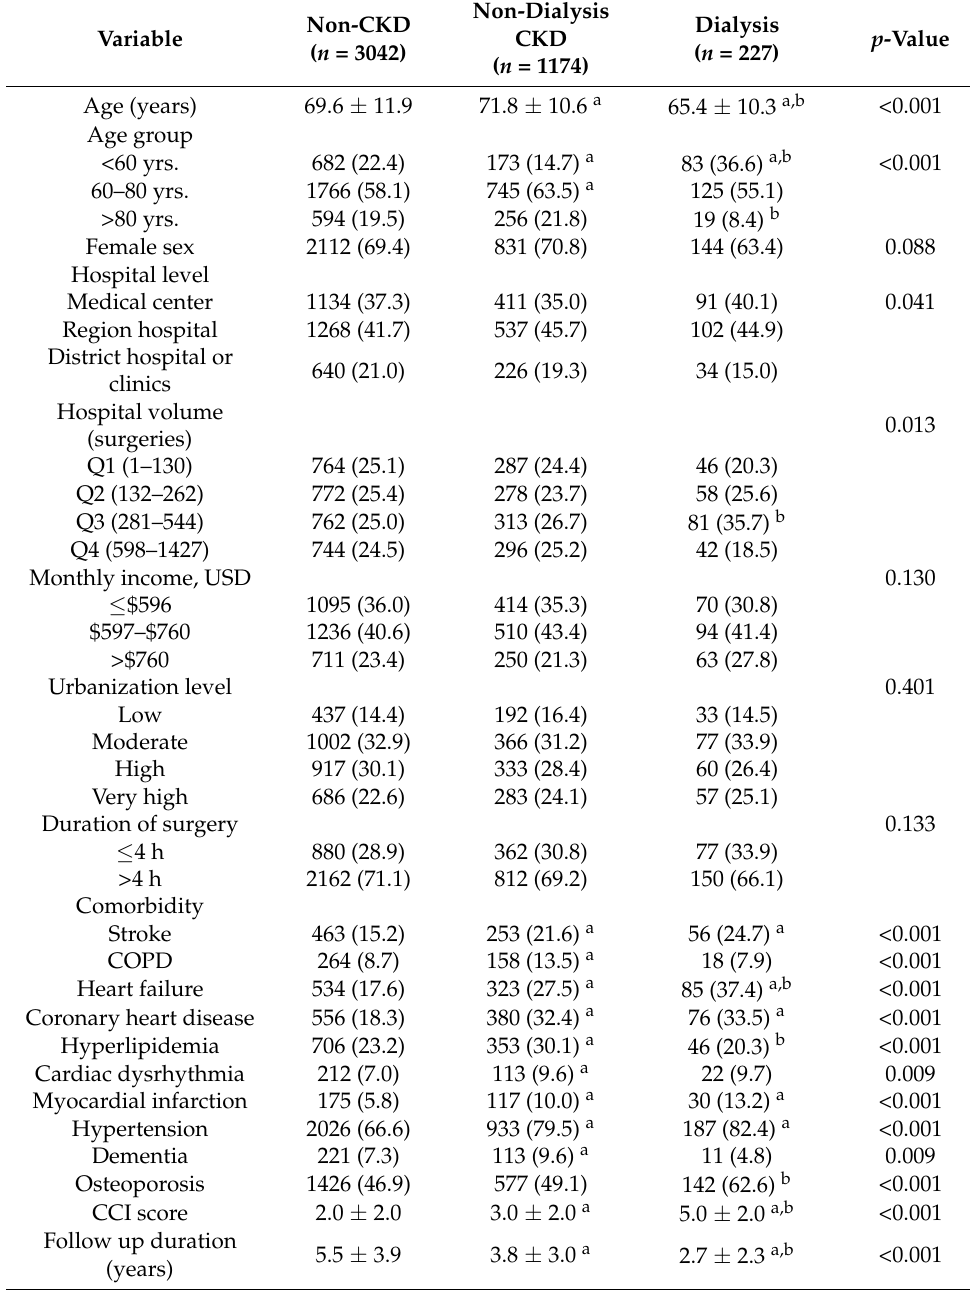
Table 1. Baseline characteristics of patients with diabetes who received shoulder arthroplasty accord- ing to renal function